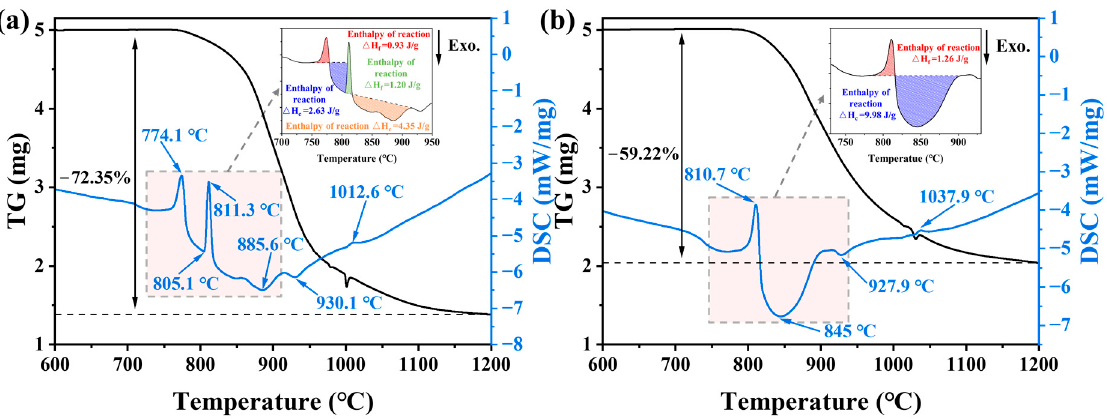
Figure 2. TG–DSC curves recorded during heating of the Mo 9 O 26 ( a ) and Mo 4 O 11 ( b ) powders up to 1200 °C at a rate of 10 °C/min in fl owing argon.